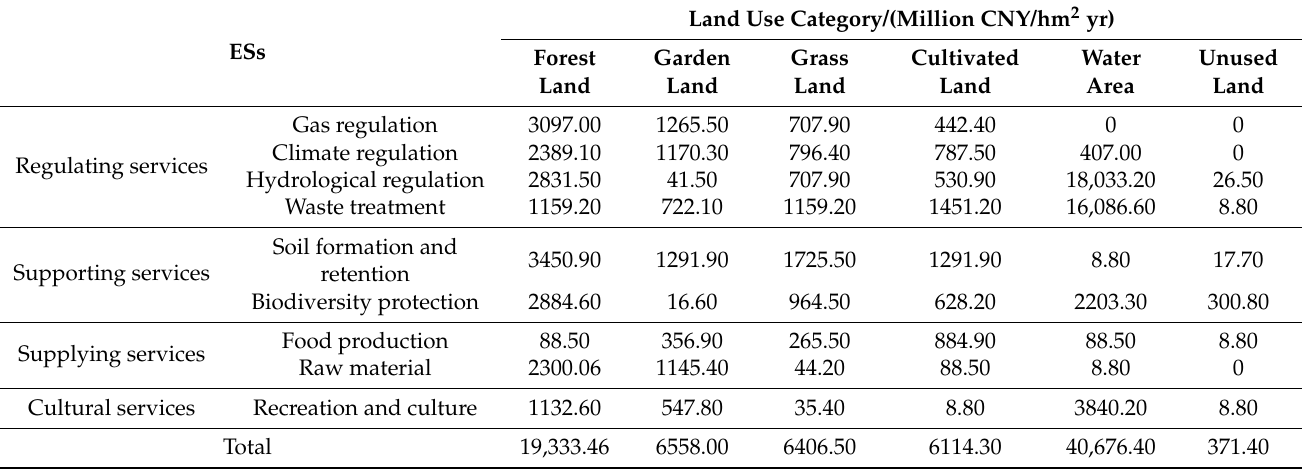
Table 1. Ecological value coefficients of different land use categories in the study area [2,10,50,51]. Land Use Category/(Million CNY/hm 2 yr) ESs Forest